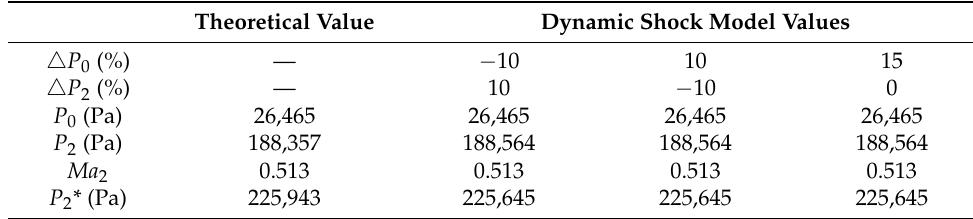
Table 1. Calculation of parameters after shock